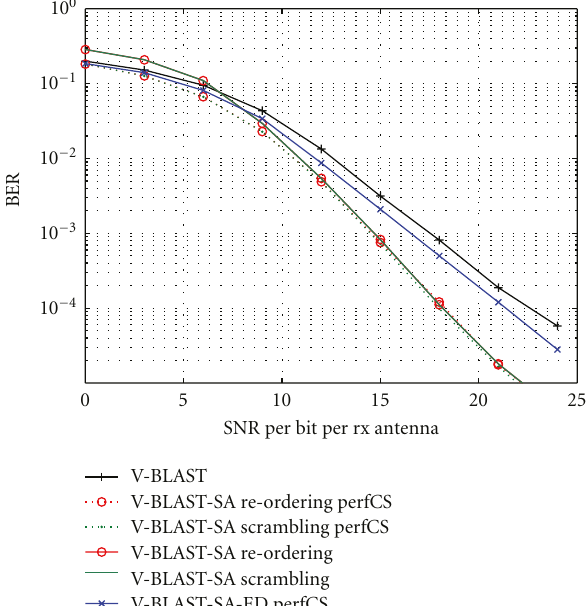
Figure 9: BER versus SNR for V-BLAST, V-BLAST-SA with reordering or scrambling, projection-based optimisation and V- BLAST-SA with Euclidean distance (ED) optimisation N = M = 5, N t = 7, D = 16, QPSK.